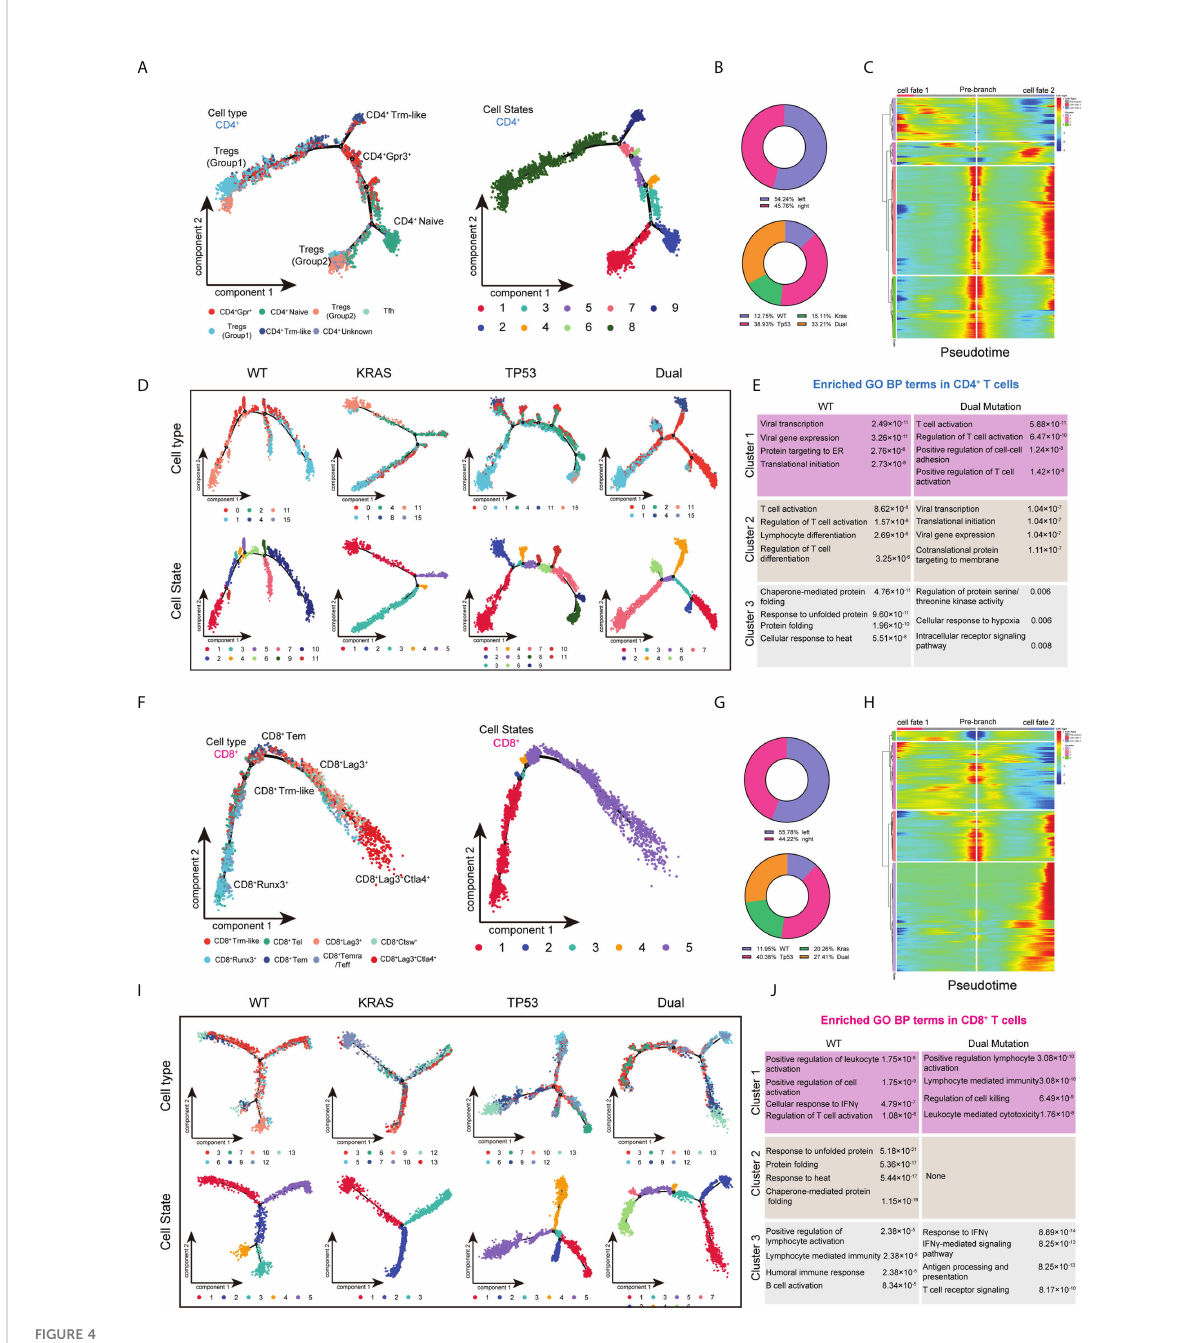
FIGURE 4 Trajectory analysis of intratumor CD4 + and CD8 + T lymphocytes cells in colorectal cancers with based on KRAS/TP53 mutation status. (A) The trajectory plot (monocle2) showed the dynamics of all tumor-in fi ltrating CD4 + T cell clusters and their pseudotime-associated cell state. (B) The proportion of CD4 + T cells based on tumor sideness and KRAS/TP53 mutation status. (C) According to the BEAM analysis, key genes were hierarchically categorized into four subclusters along the trajectory branching of CD4 + T cells. (D) The trajectory plot (monocle2) showed that the trajectory path of CD4 + T cells were distinct based on tumor KRAS/TP53 mutation status. (E) The enriched gene ontology (GO) terms in different BEAM trajectory clusters. (F) The trajectory plot (monocle2) showed the dynamics of all tumor-in fi ltrating CD8 + T cell clusters and their pseudotime-associated cell state. (G) The proportion of CD8 + T cells based on tumor sideness and KRAS/TP53 mutation status. (H) According to the BEAM analysis, key genes were hierarchically categorized into four subclusters along the trajectory branching of CD8 + T cells. (I) The trajectory plot (monocle2) showed that the trajectory path of CD8 + T cells were distinct based on tumor KRAS/TP53 mutation status. (J) The enriched gene ontology (GO) terms in different BEAM trajectory